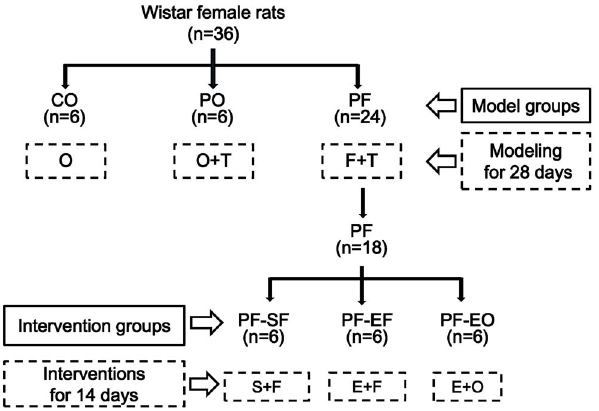
Figure 1. The experiment protocol. O: ordinary diet; F: high fat diet; T: testosterone propionate; CO: control group with ordinary diet; PO: PCOS model with ordinary diet; PF: PCOS model with high-fat diet; S: no exercise; E: exercise; PF-SF: sedentary with high-fat diet in PF rats; PF-EF: exercise with high-fat diet in PF rats; PF-EO: exercise with ordinary diet in PF rats.